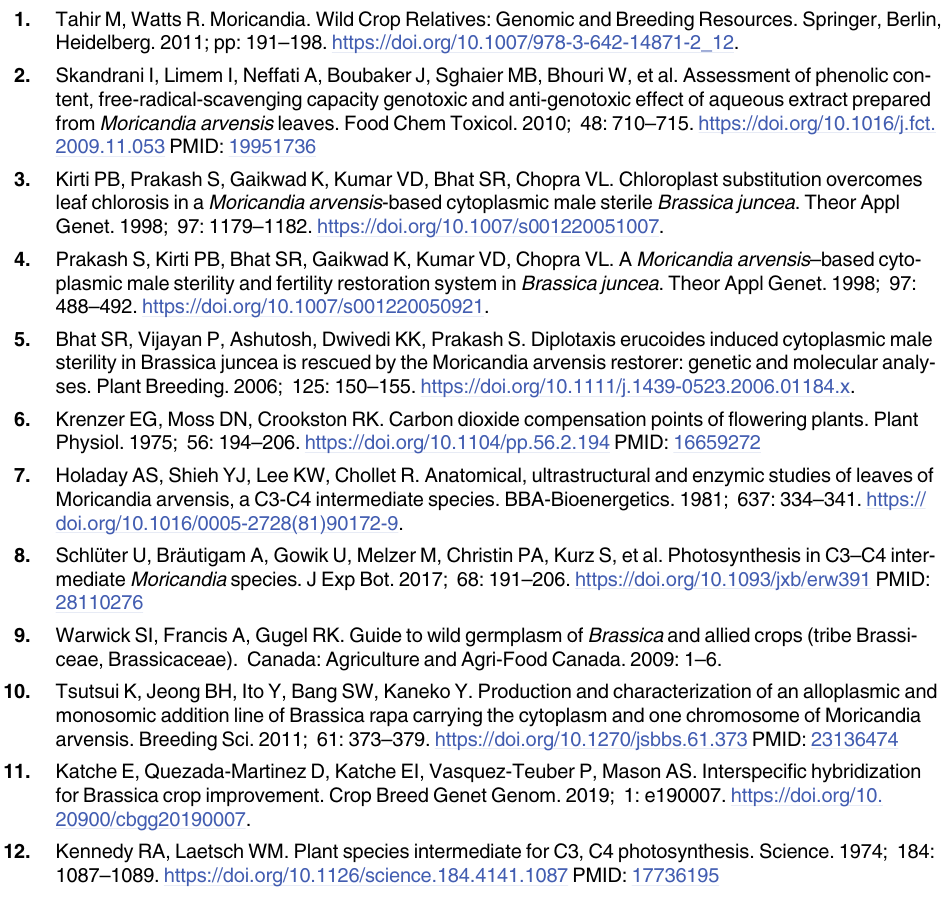
S4 Table. Summary of de novo sequencing of cp genome of Moricandia arvensis